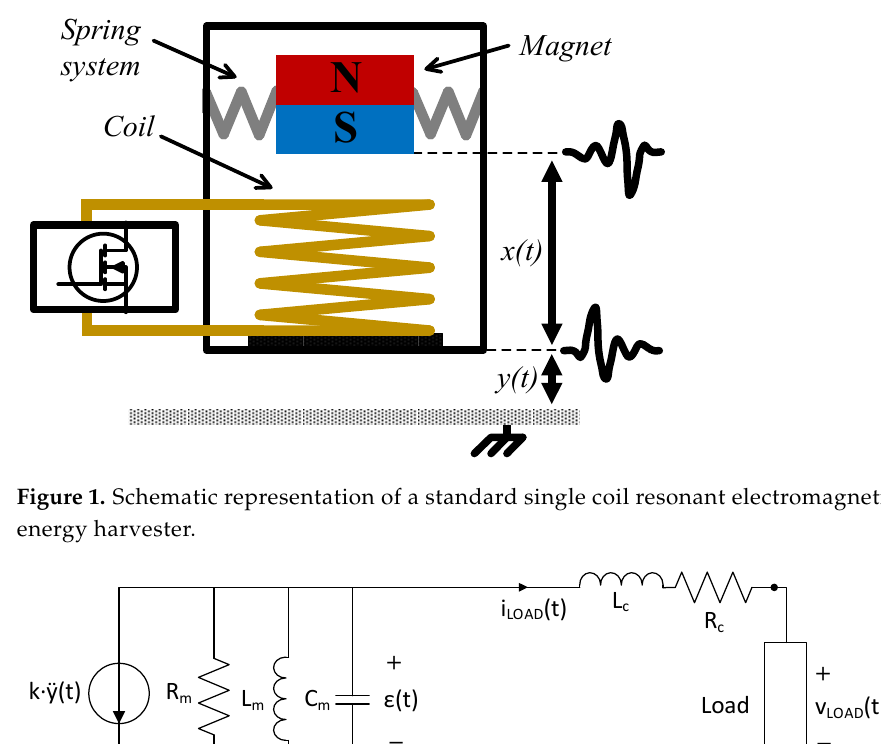
Figure 1. Schematic representation of a standard single coil resonant electromagnetic vibration energy harvester.